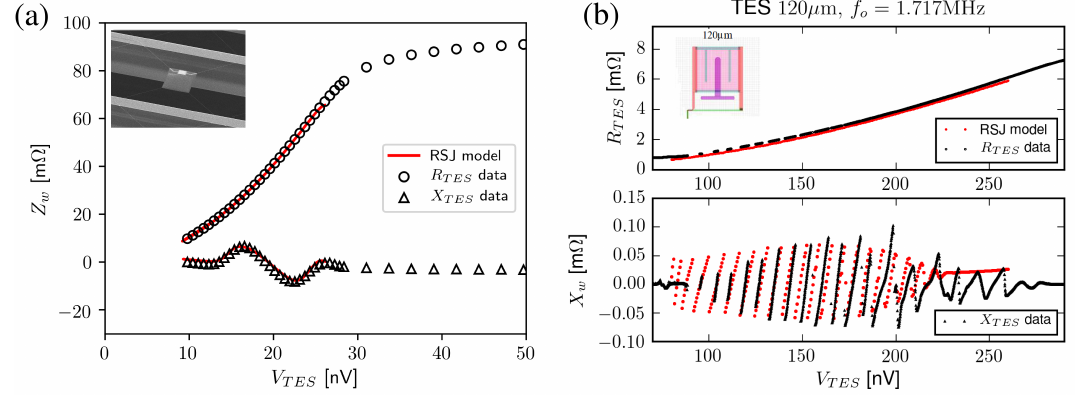
Figure 4. TES resistance R TES and reactance X TES as a function of the TES voltage for ( a ) a 50 × 50 µ m 2 bare Ti/Au TES bolometer [61] and ( b ) a 120 × 120 µ m 2 NASA-GSFC TES microcalorimeters. The detectors are biased, respectively, at 2.4 and 1.7 MHz. The red lines show the prediction from the RSJ model. Reprinted from [64] by permission from IEEE, IEEE Transactions on Applied Superconductivity. Copyright ©2018,